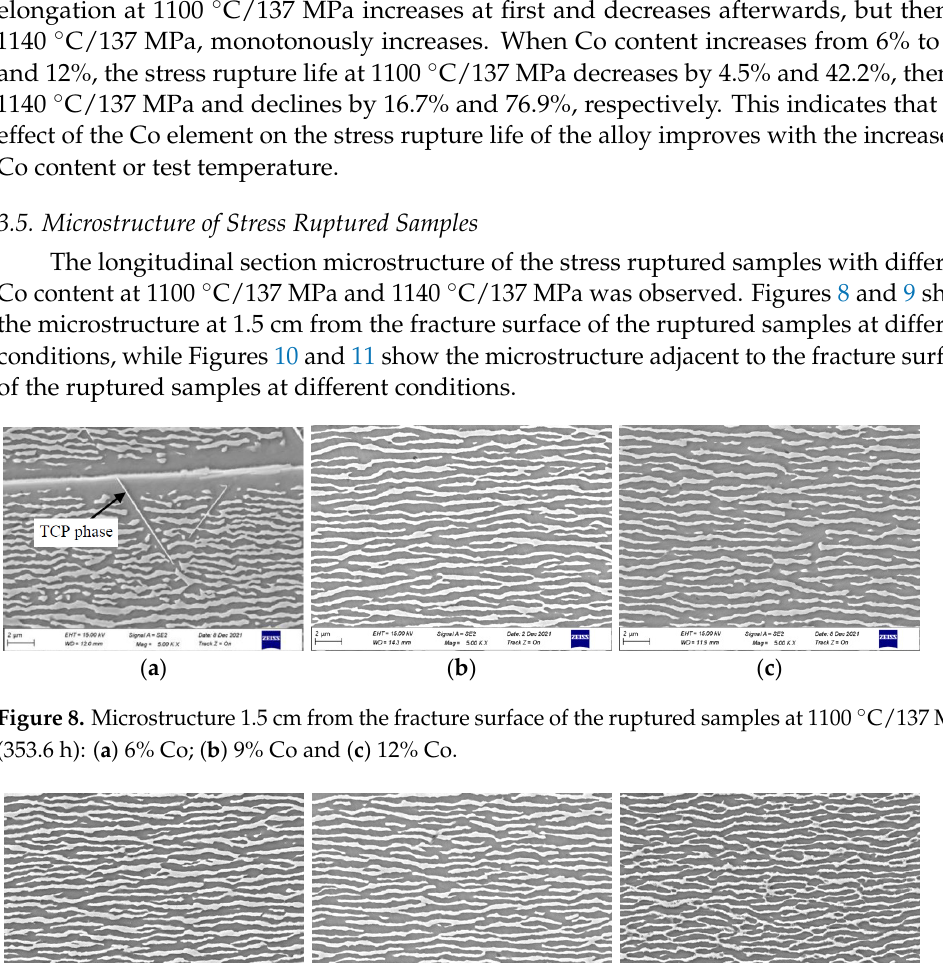
Figure 7. Influence of Co content on the stress rupture properties of the alloy at 1140 °C/137 Mpa: ( a ) stress rupture life and ( b ) elongation.